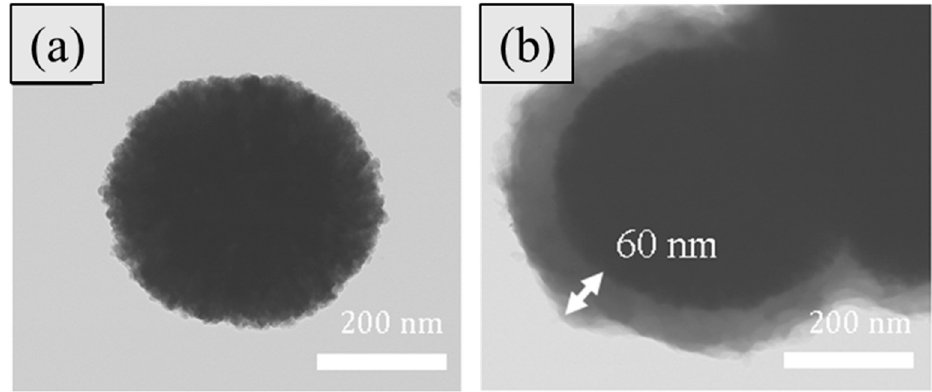
Figure 2. TEM images of ( a ) Fe 3 O 4 spheres and ( b ) Fe 3 O 4 /POA core-shell spheres.